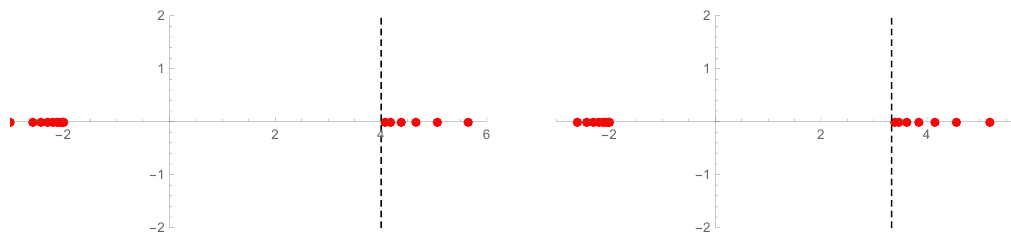
Figure 11 . The poles of the Borel-Padé approximant of the series e m truncated at 65 terms. The plots correspond to the N = 1 supersymmetric O ( N ) non-linear sigma model with N = 6 (left) and N = 7 (right). The dashed line (black) indicates the predicted position of the pole ζ = 2 / (1 − 2∆) . Note that for this model C ± = 0 so there is no IR renormalon singularity at ζ = 2 . 0